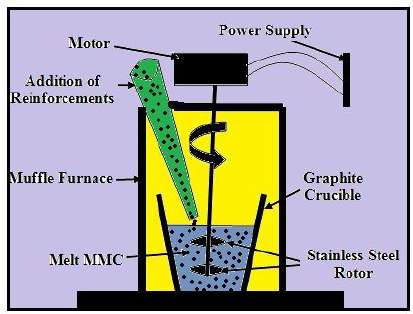
Figure 3: Schematic diagram of a mechanical stir casting set-up [16]